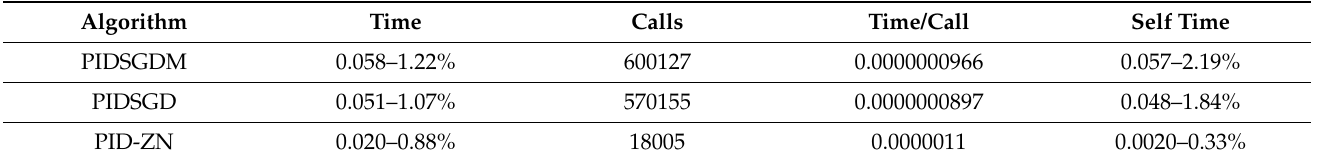
Table 7. Computational complexity